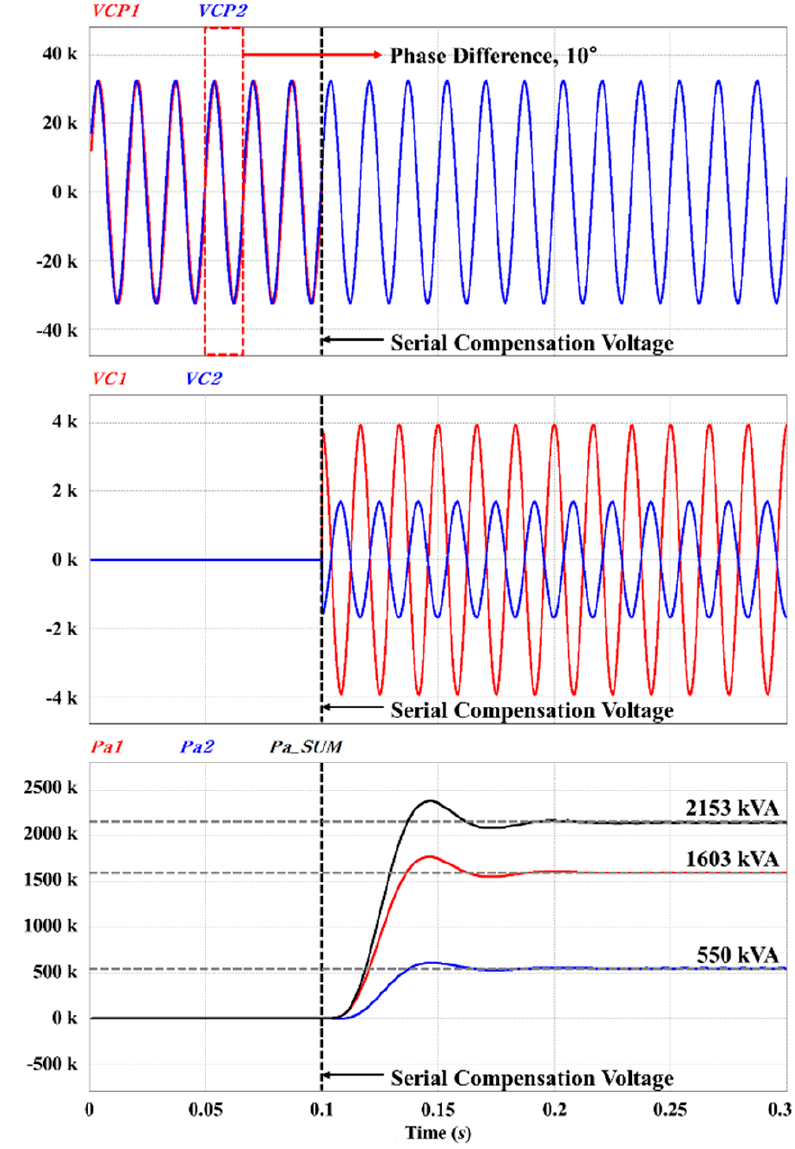
Figure 13. Connection point voltage and APC capacity at the controlled angle of 7°.